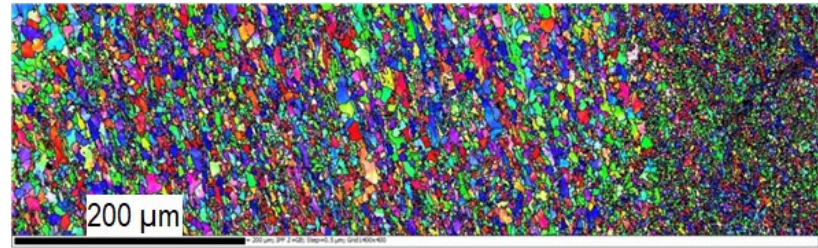
Figure 8. Detail of grain growth in the HAZ of S700MC steel.